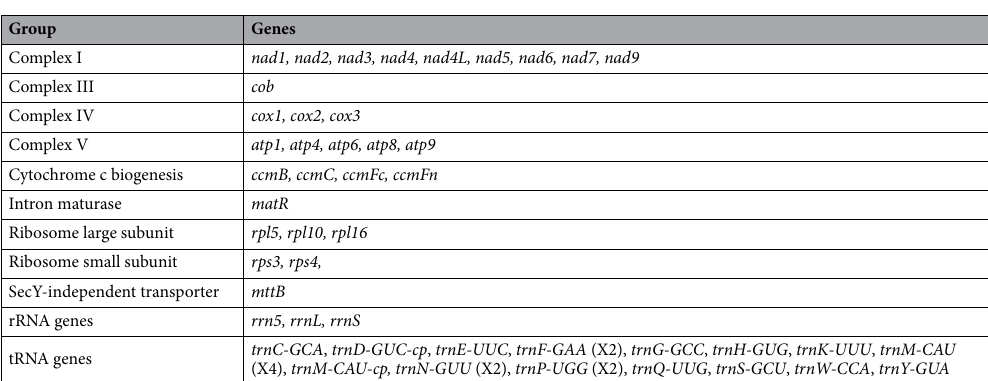
Table 2. List of genes in Garcinia mangostana var. Mesta